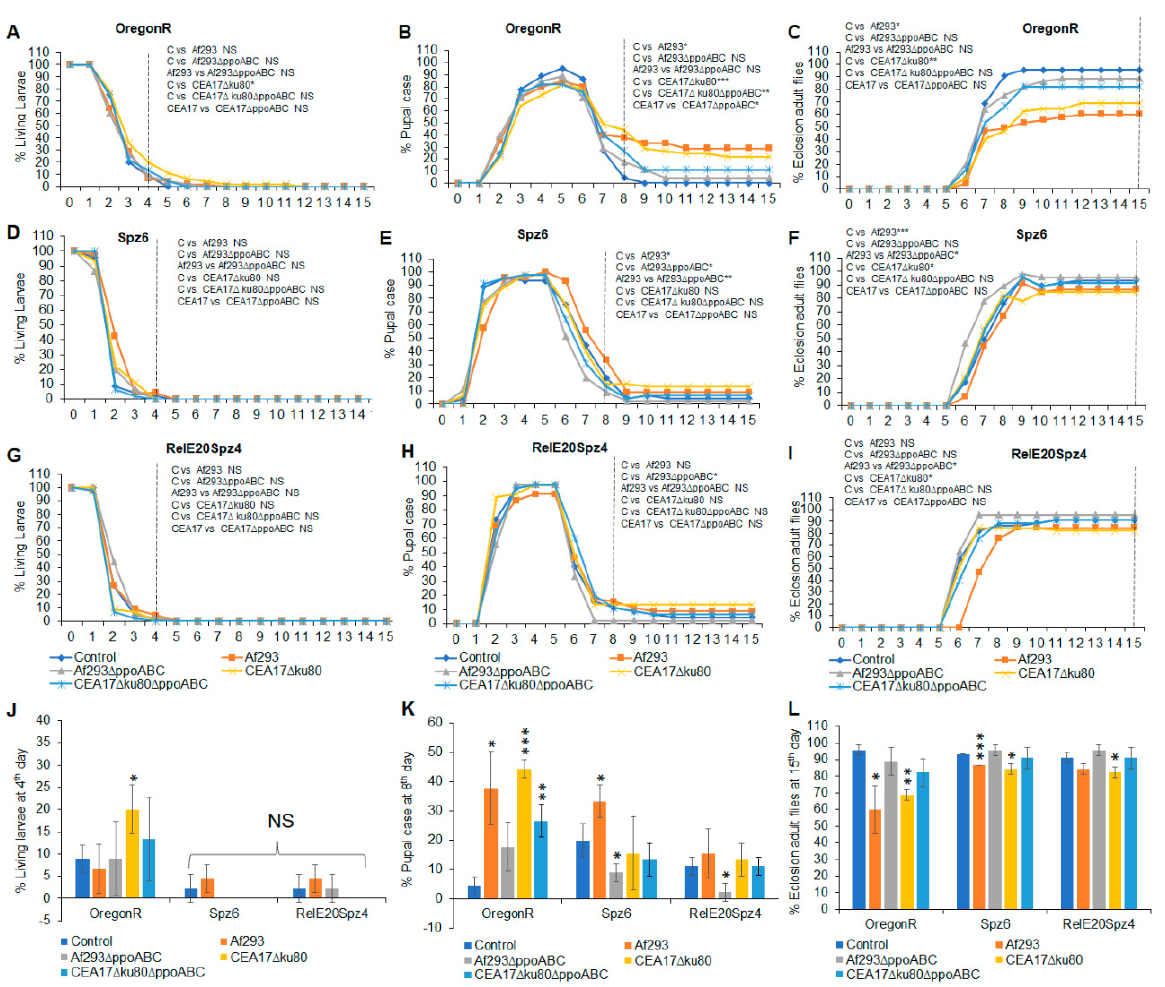
Figure 4. Effects of VOCs emitted from four different A . fumigatus strains pre − grown on PDA at 37 ◦ C for 3 days on the third instar red − eye fly larvae over 15 days of continuous exposure. The percentages of living larvae, pupal case, and eclosion adult flies are as follows: Oregon R living larvae ( A ), Spz 6 larvae ( D ), and Rel E20 Spz 4 larvae ( G ); Oregon R pupal case ( B ), Spz 6 pupal case ( E ), and Rel E20 Spz 4 pupal case ( H ); and Oregon R eclosion adult flies ( C ), Spz 6 eclosion adult flies ( F ), and Rel E20 Spz 4 eclosion adult flies ( I ). The statistical analyses are performed for the living larvae on the 4th day ( J ), the pupal case on the 8th day ( K ), and the eclosion adult flies on the 15th day ( L ). A dashed vertical line denotes the days for statistical analysis (N = 180). * Represents the significant differences between different treatments, where 0.005 < * p < 0.05, 0.0005 < ** p < 0.005, *** p < 0.0005; NS, p > 0.05. 3.4. Comparison of Eclosion Rates of the White-Eyed and Red-Eyed Drosophila Flies Exposed to VOCs from Wild-Type and A. fumigatus Mutants The eclosion rates of the six Drosophila strains after 15 days of continuous exposure to VOCs emitted by wild-type or the A . fumigatus oxylipin mutants are shown in Figure 5. The highest eclosion rates were exhibited by larvae grown in a common atmosphere with the VOCs emitted by the triple oxylipin mutants (Af293 ∆ ppoABC or CEA17 ∆ ku80 ∆ ppoABC ). In general, larvae from the red-eyed flies were more resistant to fungal VOCs than those of white-eyed flies. When focusing just on the flies carrying the white-eyed genotype, larvae that carried mutations in the NOS or Imd immune pathways ( Rel E20 ) were more resistant to the toxigenic effects of fungal VOCs than those of the white-eyed w 1118 flies with a wild-type immune system. When focusing just on flies carrying the red-eyed genotype, flies carrying the Toll mutation Spz 6 or a double mutation Rel E20 Spz 4 in both the Imd